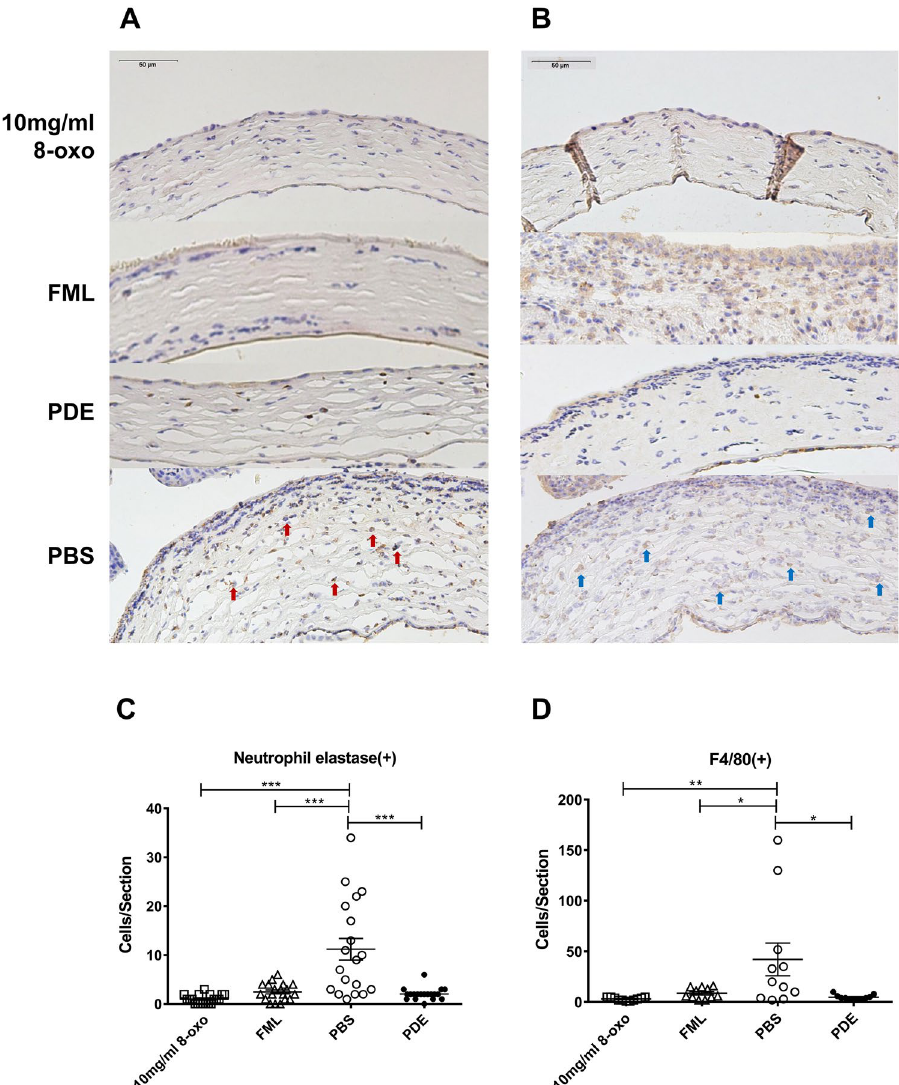
Figure 4. Immunohistological analysis of cornea 1 week after treatment of ocular alkali burn model with topical 8-oxo-2 ′ -deoxyguanosine (8-oxo-dG) or corticosteroid. Representative images of central cornea stained with ( A ) anti-neutrophil elastase and ( B ) anti F4/80 in 8-oxo-dG (10 mg/mL), FML, PDE, and PBS groups. Red arrow: neutrophil elastase positive cells, Blue arrow: F4/80-positive cells. ( C , D ) Comparison of neutrophil elastase and F4/80-positive cells in the central cornea. Data are means ± standard error of the mean (SEM). * p < 0.05, ** p < 0.01, and *** p < 0.001. 8-oxo: 8-oxo-dG. FML fluorometholone 0.1% (1 mg/mL), PDE prednisolone acetate 1% (10 mg/mL), PBS phosphate-buffered